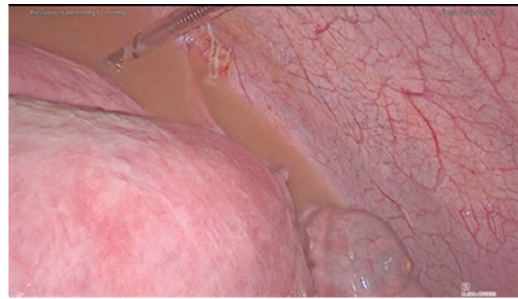
Figure 1. Uroperitoneum. Figure 1.